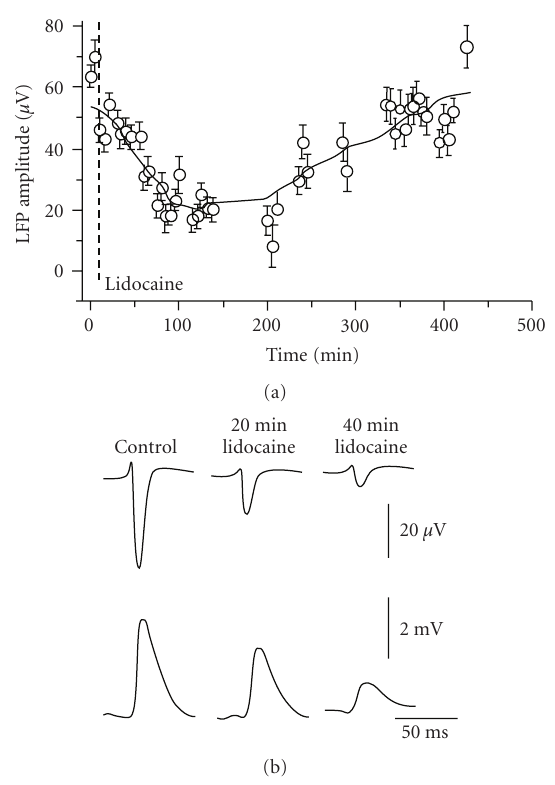
Figure 1: (a) Absolute value of local field potential amplitude in barrel cortex (one point represents 60 responses). (b) Simultaneous recording extra (top) and intracellular (bottom) during lidocaine